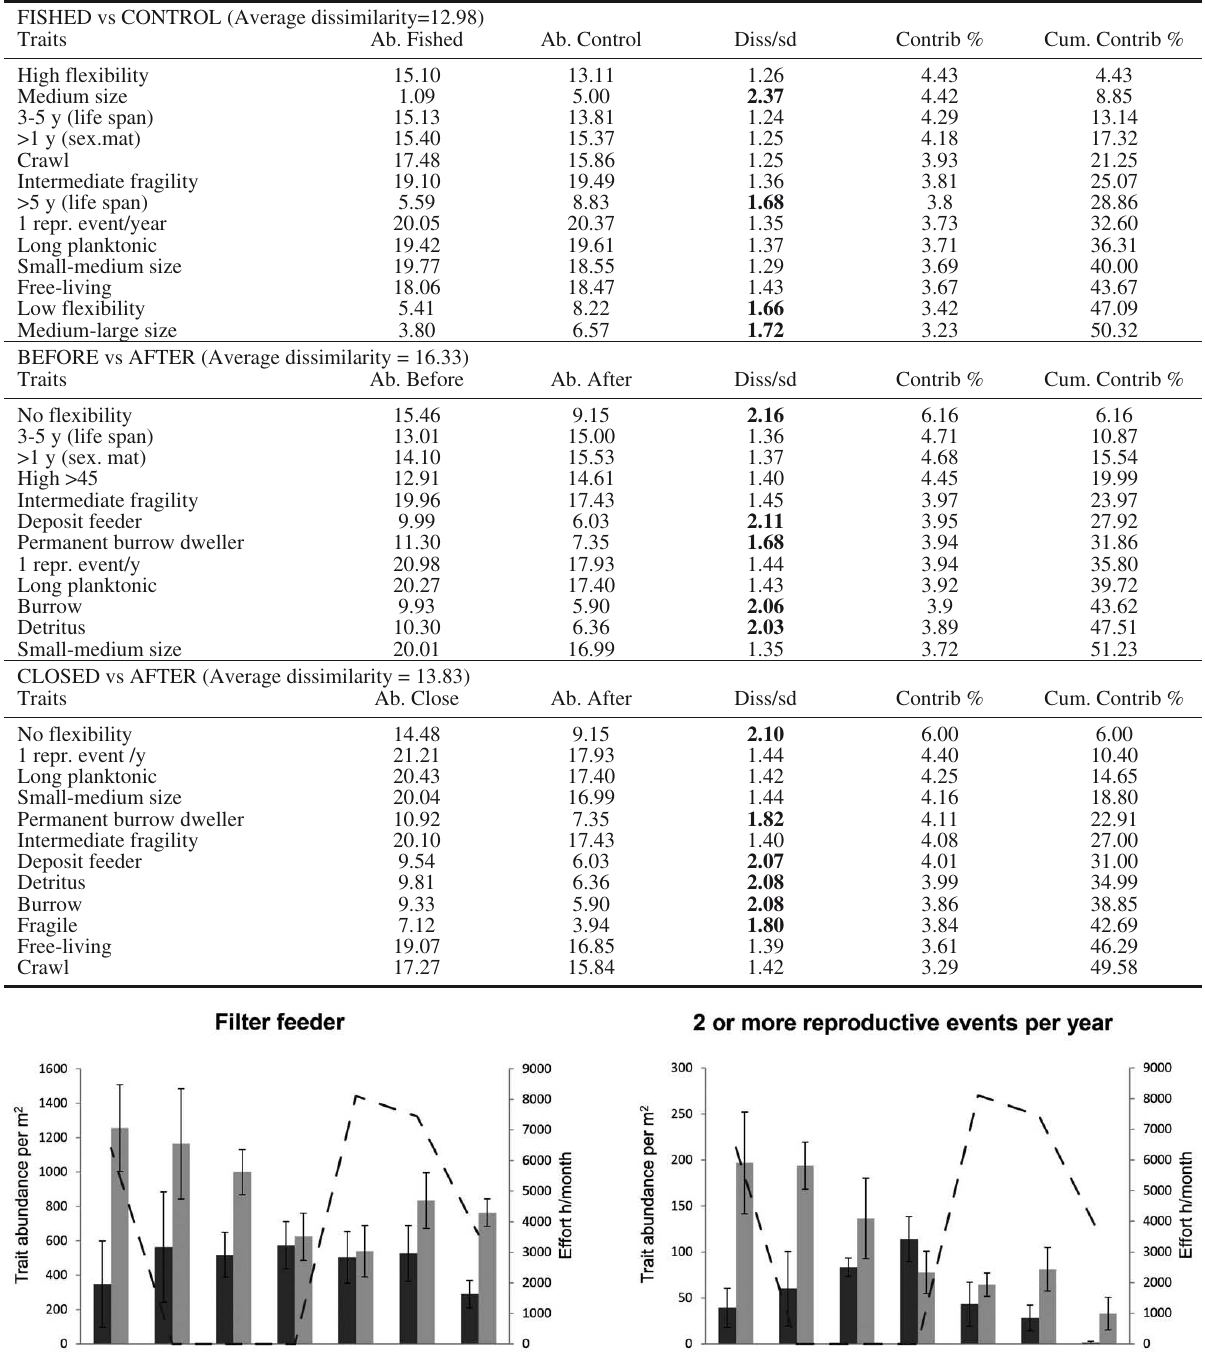
Table 5. Results of SIMPER analysis for epifaunal traits abundance, comparing fished (Ab. Fished) and control (Ab. Control) sites. All analyses were based on the whole data set. Cut-off to traits list applied at 50% of cumulative contribution to dissimilarity (Contrib.%); traits with a ratio of dissimilarity to standard deviation (diss/sd) >1.5 are highlighted in bold. FISHED vs CONTROL (Average dissimilarity=12.98) Traits